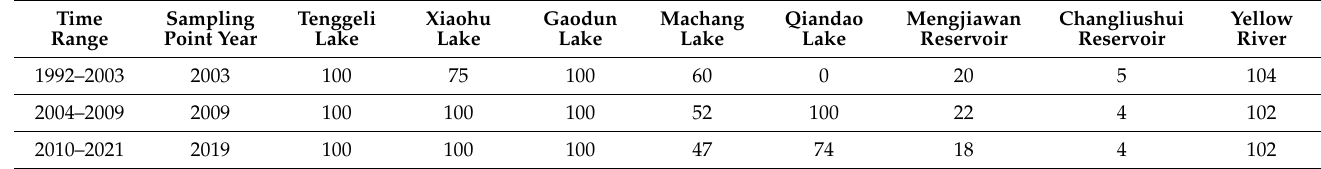
Table 2. Number of sampling